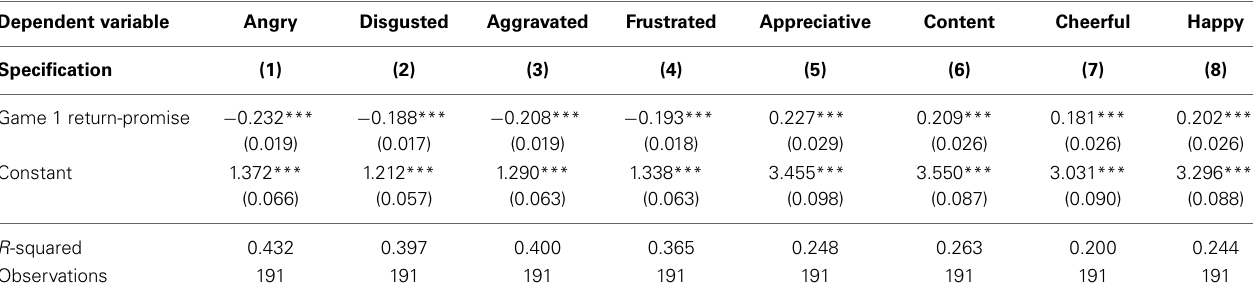
Table 3 | Regression of investors’ emotions on signal value